Question: Briefly state, in one sentence, what is plotted here.
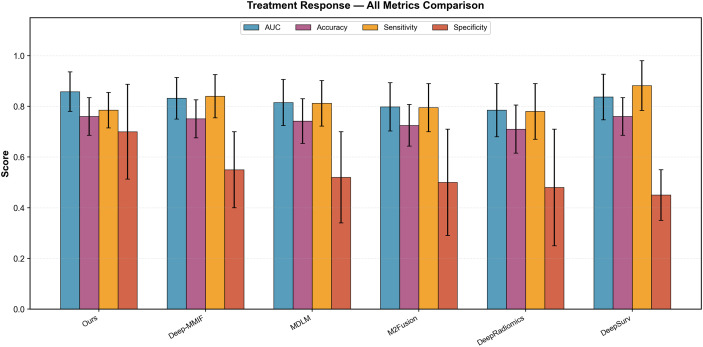
Answer: Comparison of classification metrics across the proposed model and state-of-the-art multimodal baselines.